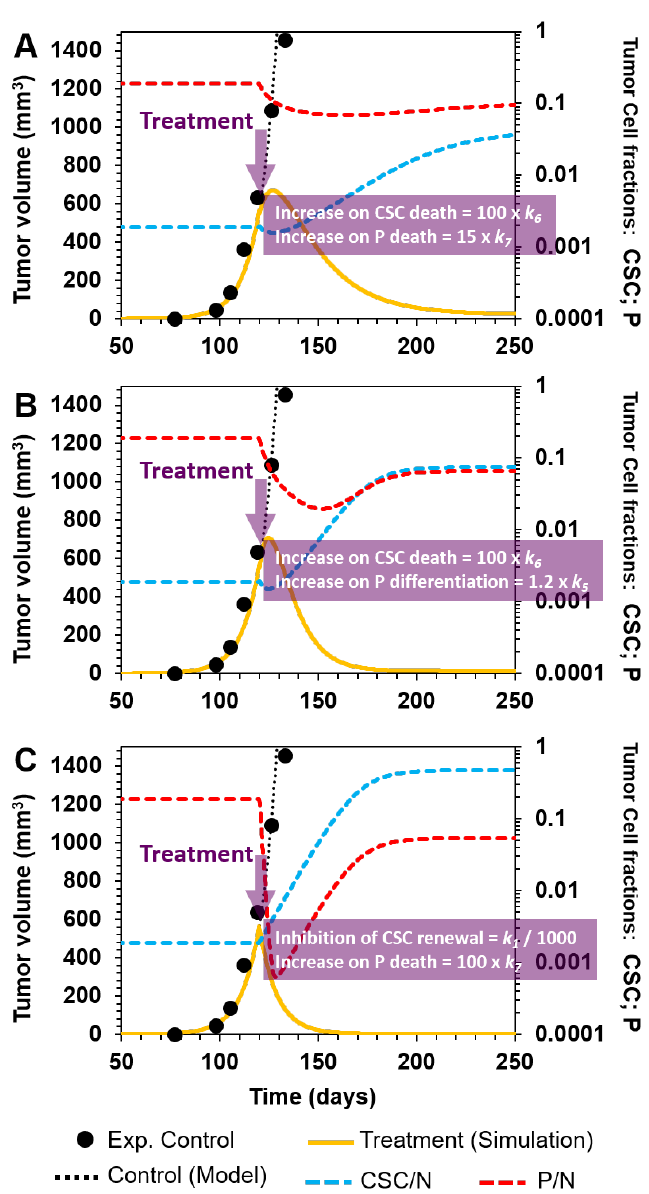
Figure 6. Combination therapy against CSCs and P cells. Yellow curves represent simulations of the simultaneous targeting of CSCs and P cells at day 120 (purple arrow). Scenario ( A ): Selective killing of CSCs and P cells by a 100- and 15-fold augmentation of their corresponding death rate kinetic parameters, k 6 and k 7 , respectively. Scenario ( B ): Enhancement of P cell differentiation into D cells by increasing k 5 by 20% and the selective elimination of CSCs by a 100-fold augmentation of k 6 . Scenario ( C ): Inhibition of symmetrical CSC renewal by a 1000-fold reduction in k 1 and selectively killing P cells by increasing k 7 100-fold. For all cases: Experimental control data are represented by black points; model curve fit to experimental control data by the dotted black line; model curve for treatment simulation by solid yellow lines; and P and CSC tumor fractions by dashed red and blue lines, respectively.